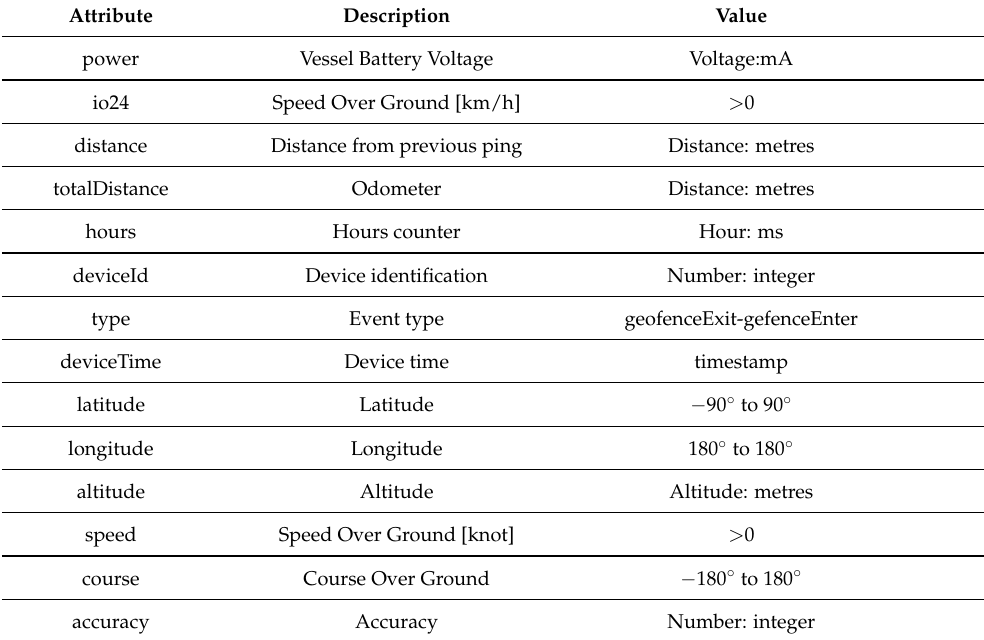
Table A1. Cont. Attribute Description